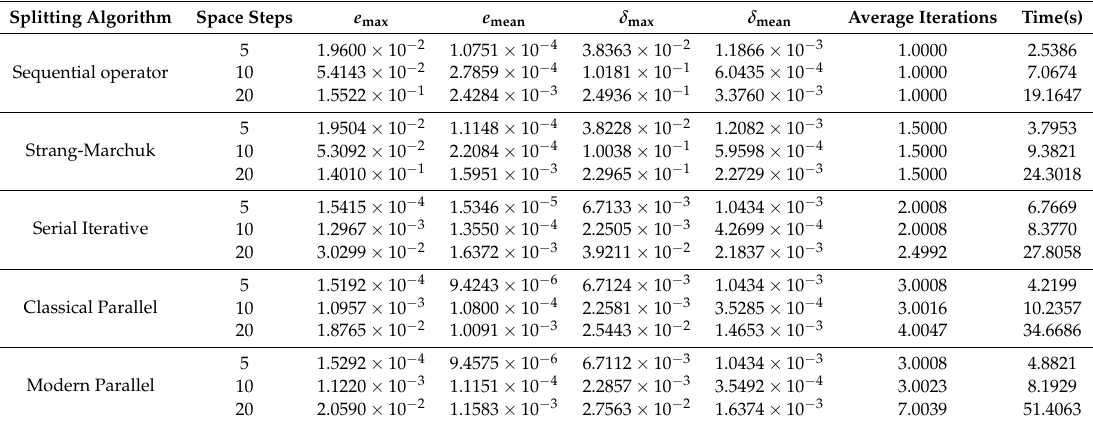
Table 12. Mixed convection-diffusion and Burgers’ equation. Results of the directional decomposition using the second order scheme for the spatial discretization, with 1280 time subintervals and different number of spatial steps.